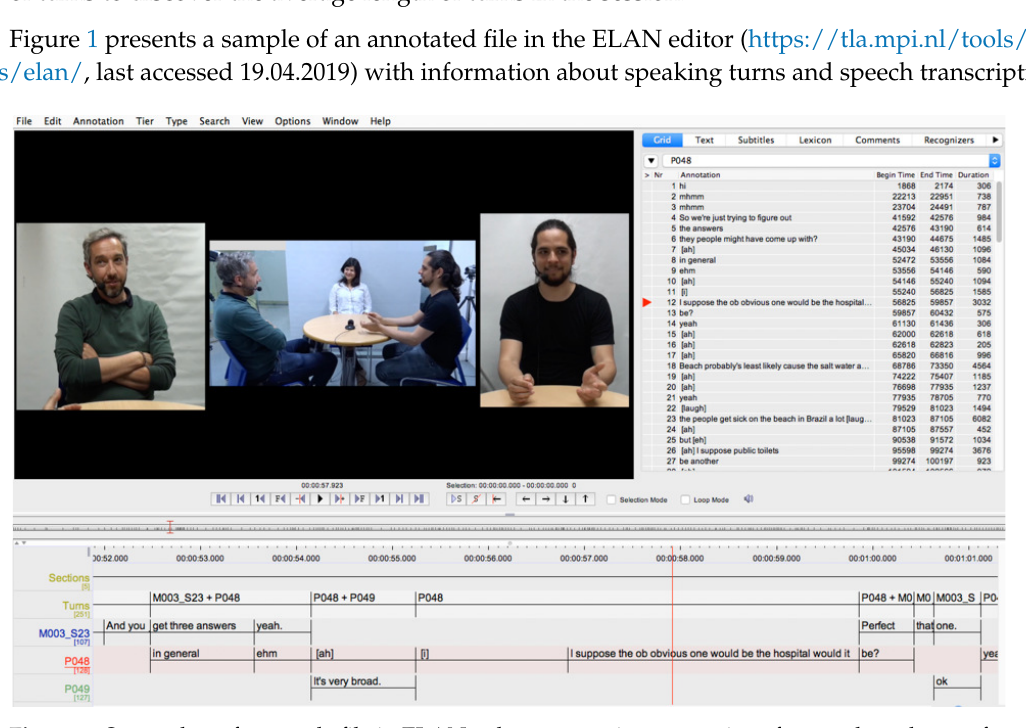
Figure 1. Screenshot of a sample file in ELAN, where transcript annotations for words and turns for each speaker may be